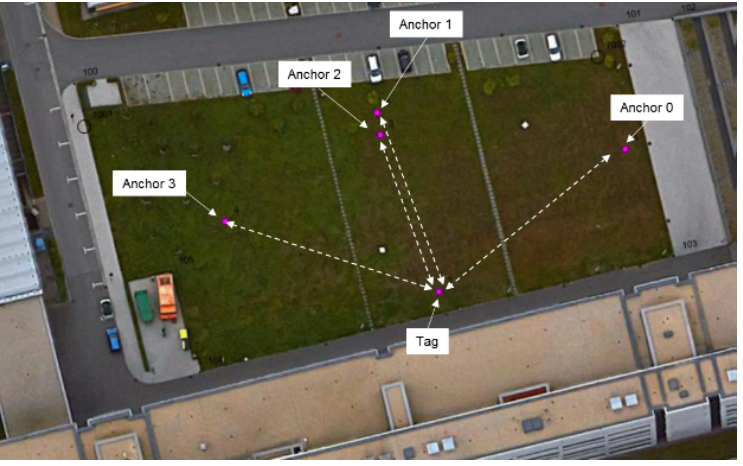
Figure 4. Decawave nodes at the inner courtyard of the university (Scenario